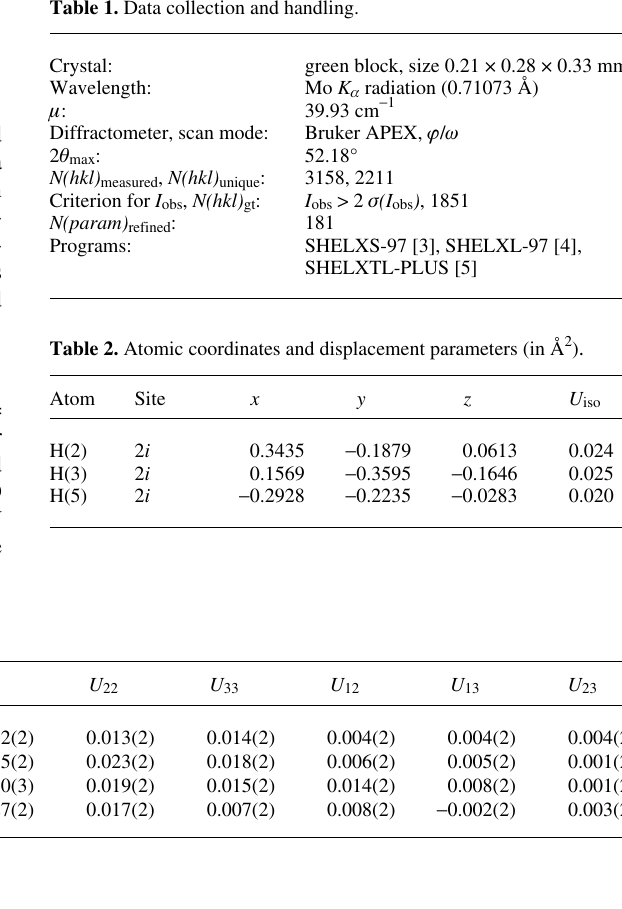
Table 1. Data collection and handling.